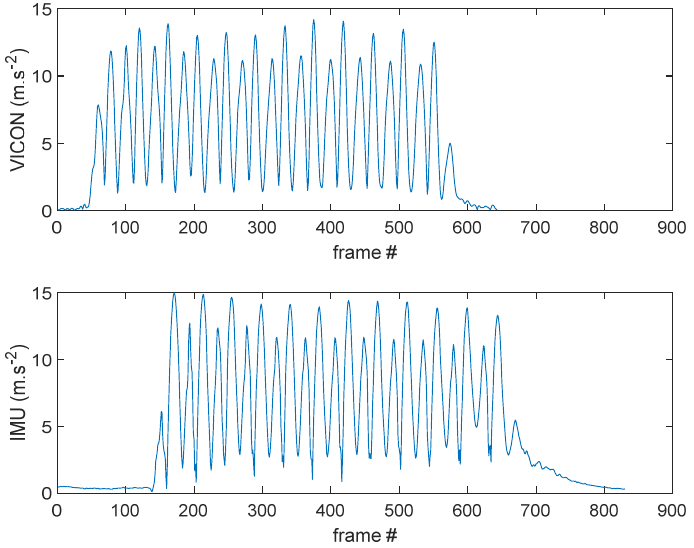
Figure A1. VICON and IMU signals before cross-correlation synchronization .